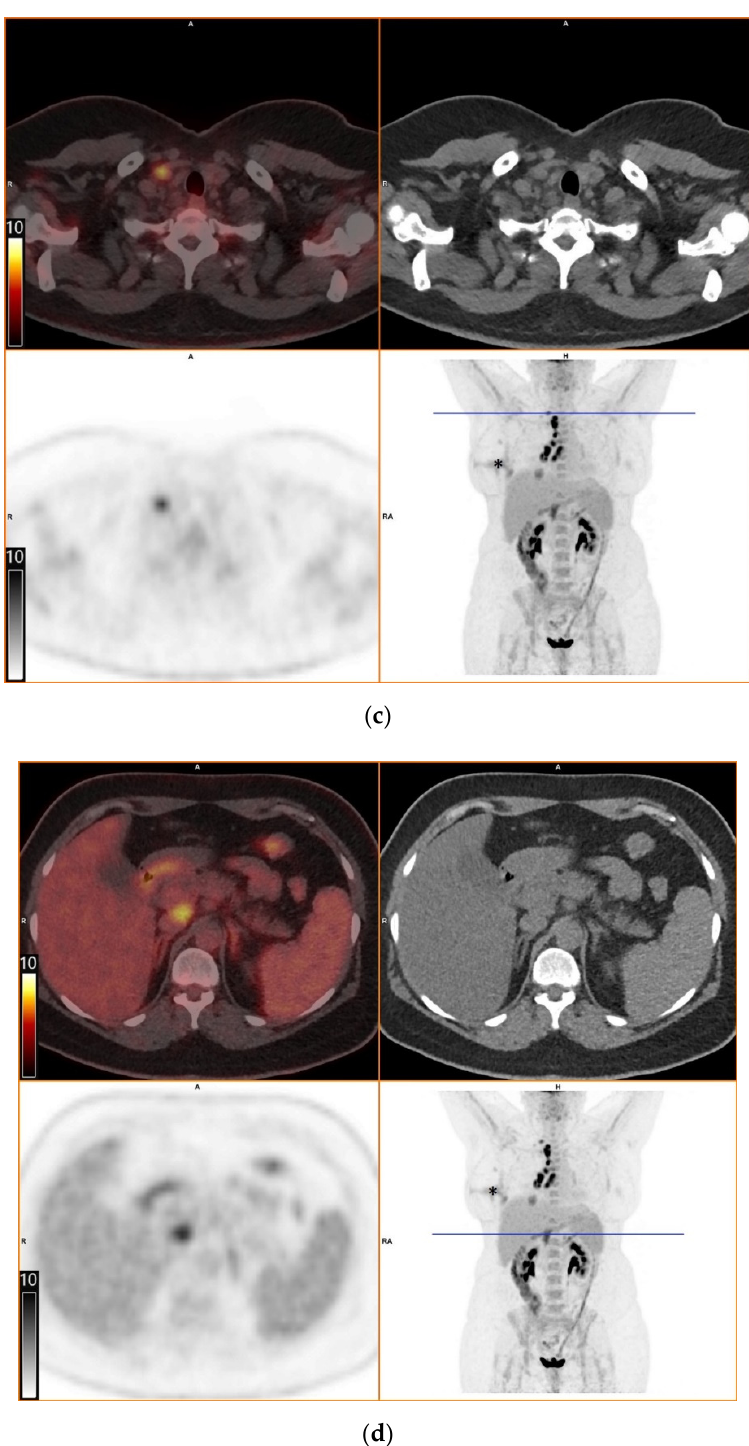
Figure 1. [ 18 F]FDG-PET/CT. Upper left: PET and CT fusion images. Upper right: CT images. Lower left: PET images. Lower right: Maximum intensity projection. Blue line: Axial imaging level. Scale bars: Standardized uptake value. Star: Postinterventional diffuse uptake of the right thoracic wall after chest tube placement. ( a ) Moderate uptake in a solitary solid pulmonary lesion with irregular margins in the right lower lobe of the lung ( b ) Greater uptake in the draining lymph nodes right interlobar, right hilar and mediastinal ( c ) A further draining right supraclavicular lymph node showing high uptake as well ( d ) Moderate uptake in a precaval abdominal lymph node.